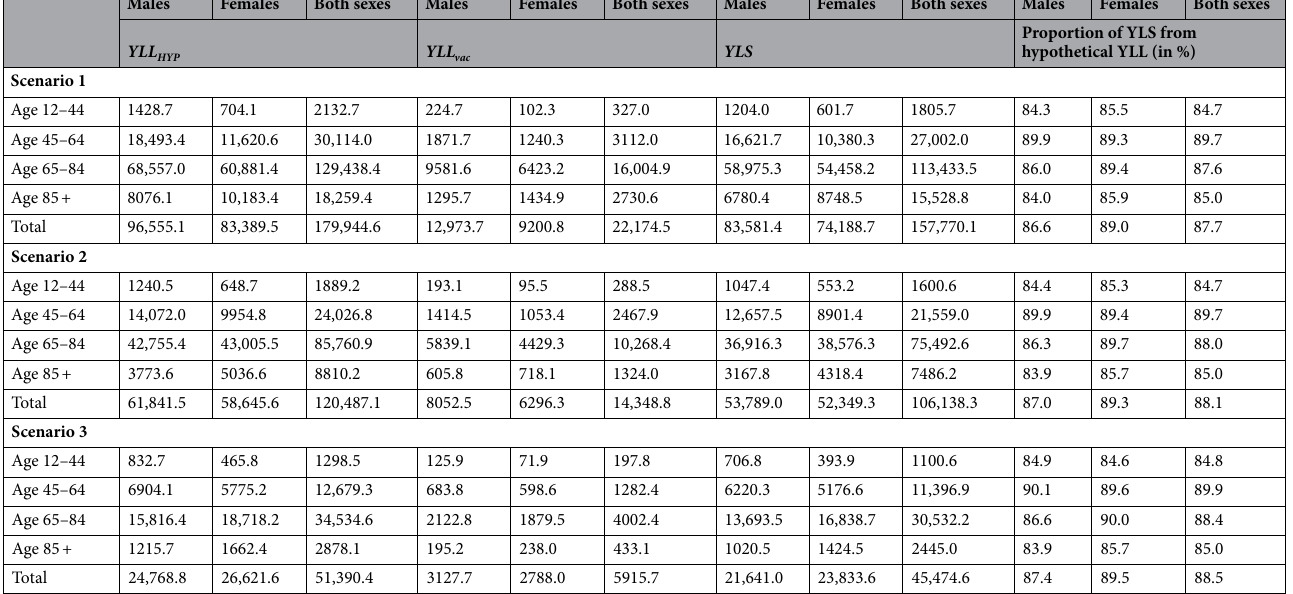
Table 3. The hypothetical years of life lost ( YLL HYP ), years of life lost ( YLL vac ), and years of life saved through COVID-19 vaccination ( YLS ) in the population with completed vaccination during the period of October 1